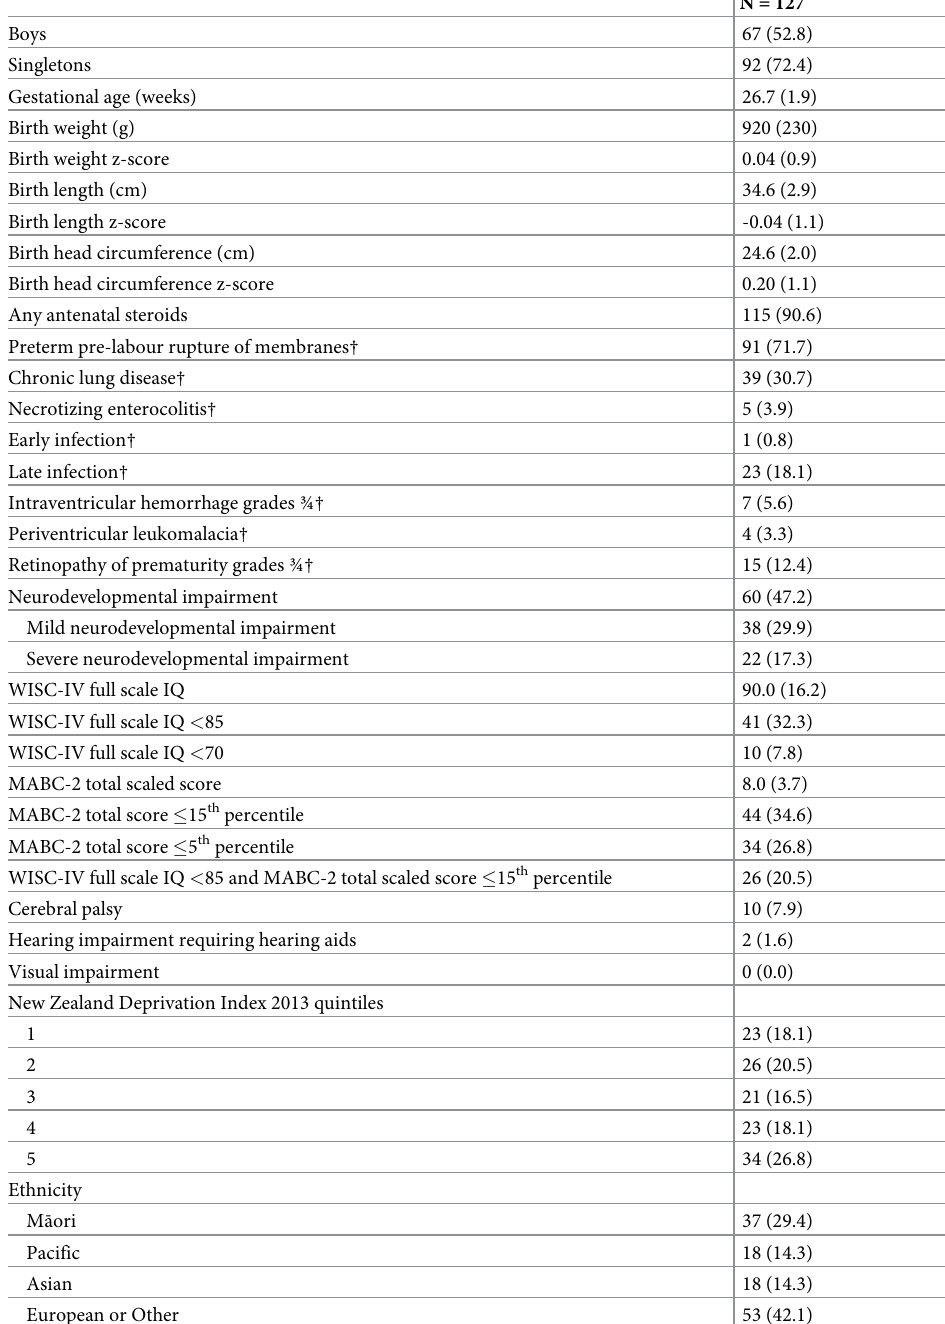
Table 1. Participant